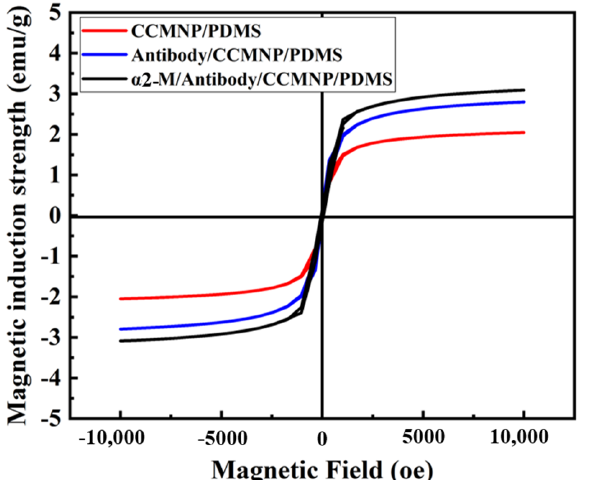
Figure 10. Hysteresis loops measurement before and after antigen detection.